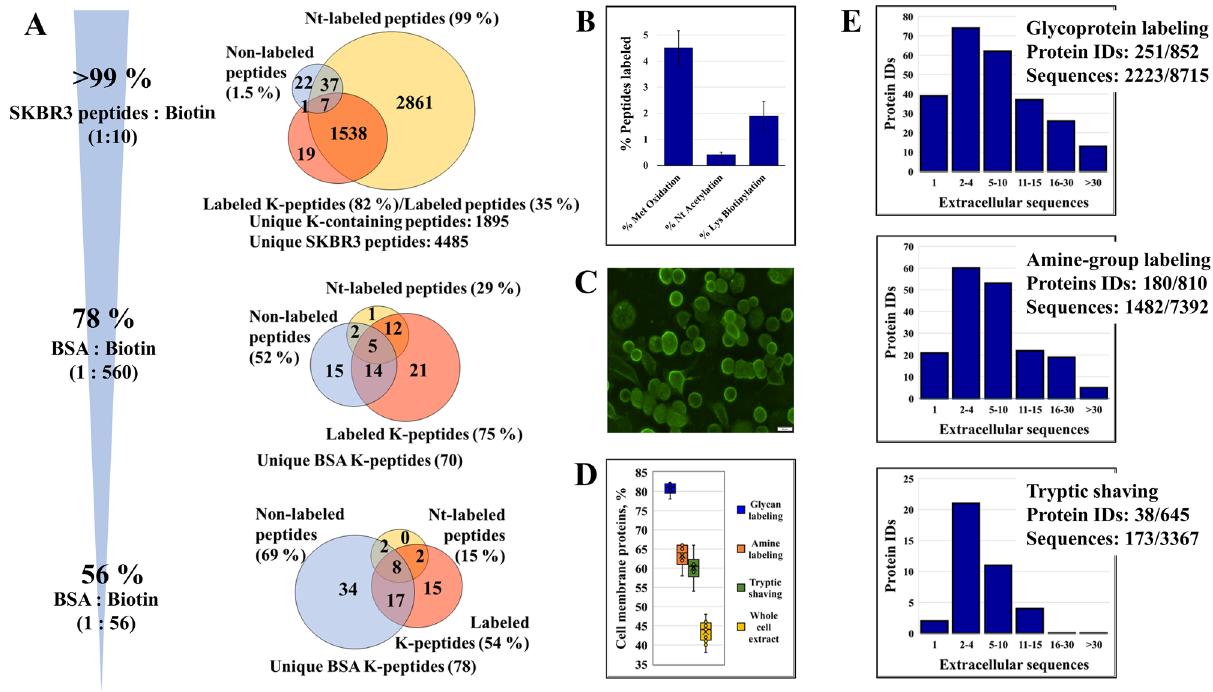
Figure 2. Cell membrane protein labeling efficiency and enrichment in extracellular sequences. ( A ) Percent peptides carrying a biotinylation-induced label in an SKBR3 cell extract and in BSA tryptic digests using various peptide/protein:biotin molar ratios (applicable to the amine group labeling method); the Venn Diagrams represent the number of labeled Lys-containing peptides (+ 87.998 Da), peptides labeled at the N-terminus (+ 87.998 Da), and the number of non-labeled peptides. ( B ) Percent peptides carrying a PTM: Met oxidation, peptide Nt acetylation, and Lys biotinylation (case of the amine group labeling method with on-bead proteolytic digestion); the error bars represent the SD of biological replicates. ( C ) SKBR3 cells labeled by alkoxyamine- PEG4-biotin and conjugated with streptavidin antibody-Alexa Fluor™ 488. ( D ) Cell membrane protein enrichment effectiveness represented by the number of cell membrane proteins in the top 100 most abundant proteins (abundance determined by the number of matching unique peptides). ( E ) Histograms of protein IDs matched by different numbers of extracellular peptide sequences (with extracellular sequences detected/ total); extracellular sequence assignments were made based on topological domain information extracted from